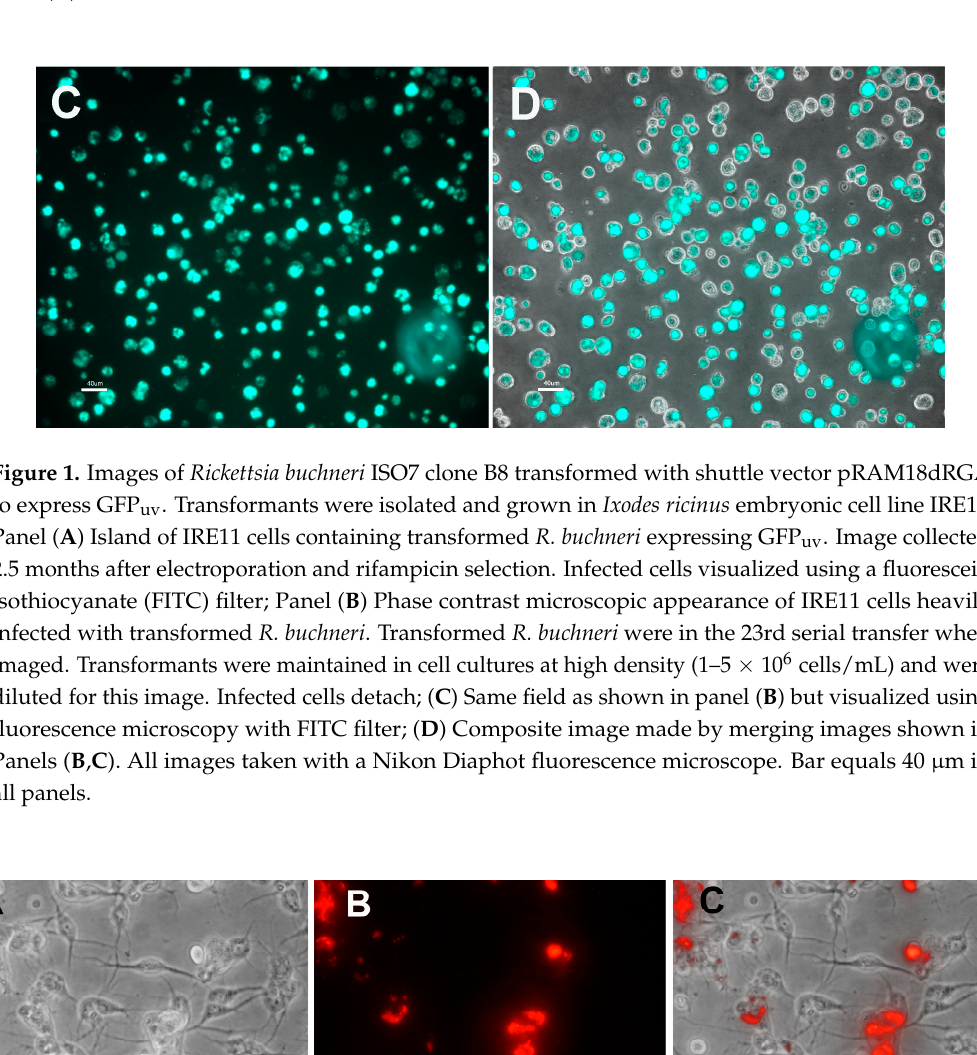
Figure 2. Image of Ixodes scapularis cells (ISE6) infected with Rickettsia peacockii expressing the far red fluorescent protein mKATE. Panel ( A ) Phase contrast microscopic appearance of ISE6 cells infected with transformed R. peacockii. Transformed R. peacockii were in the 23rd serial transfer when image was collected. Transformant is maintained in cell layers seeded at high cell density (1–5 × 10 6 cells per mL); ( B ) Same field as shown in panel B but visualized using fluorescence microscopy with TRITC filter; ( C ) Composite image made by merging images shown in Panels ( A , B ). All images taken using a Nikon Diaphot fluorescence microscope. Bar equals 40 µm in all panels.